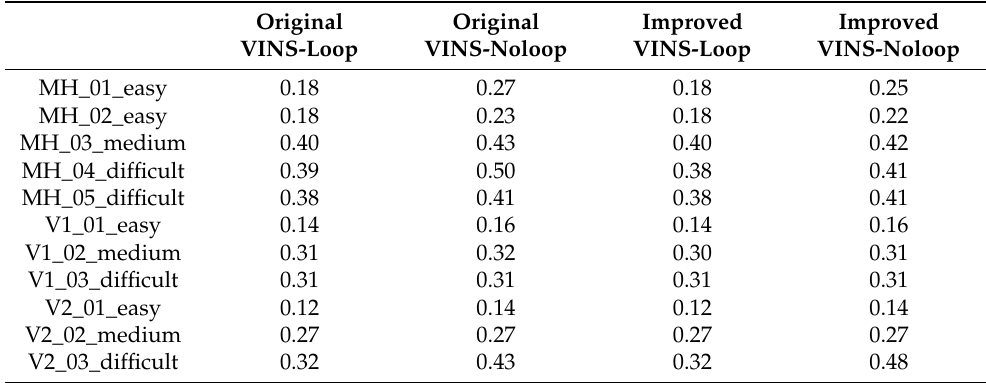
Table 1. The Absolute Pose Error (APE) of the original algorithm is compared with that of the improved algorithm in the EuRoC dataset. (Unit: meter).